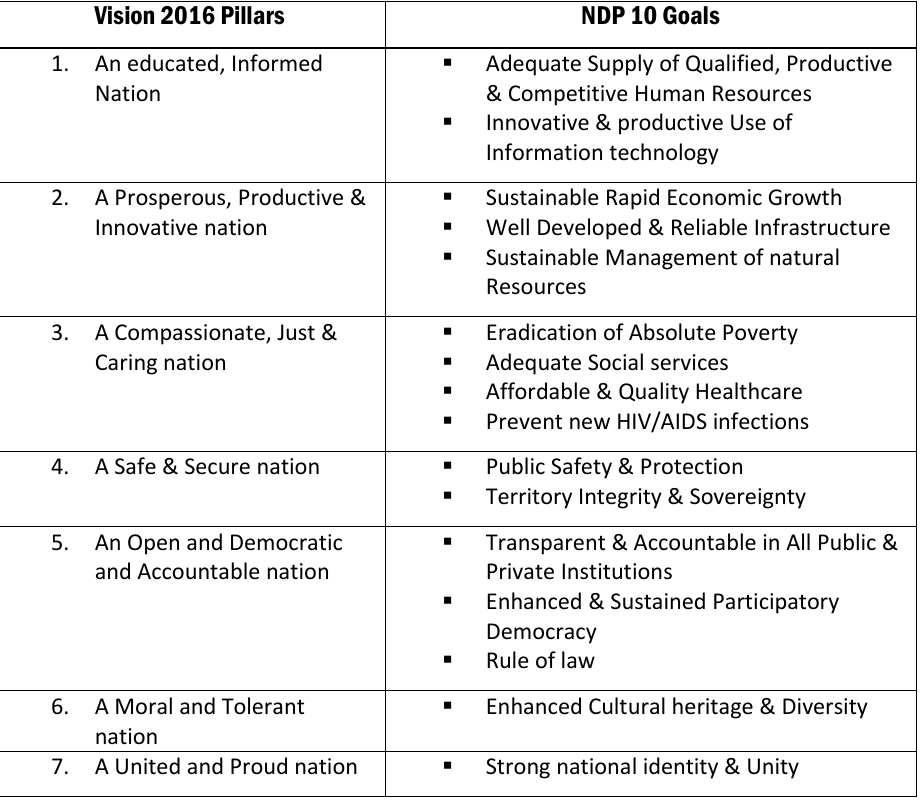
Table 6: Botswana’s Vision 2016 and National Development Goals Vision 2016